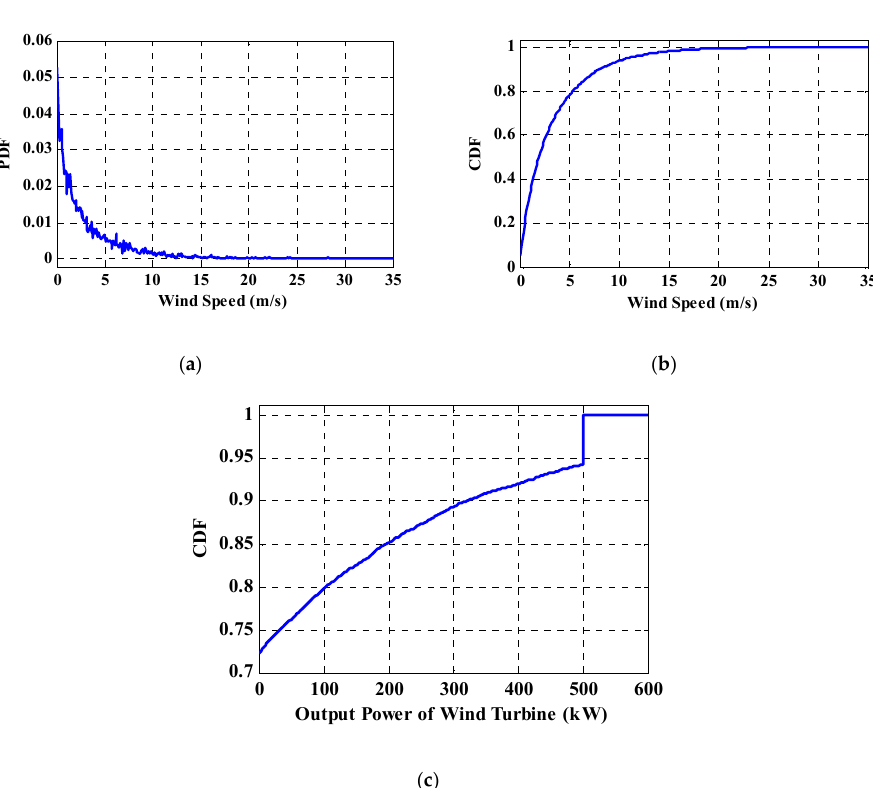
Figure 4. Wind speed for each sample.